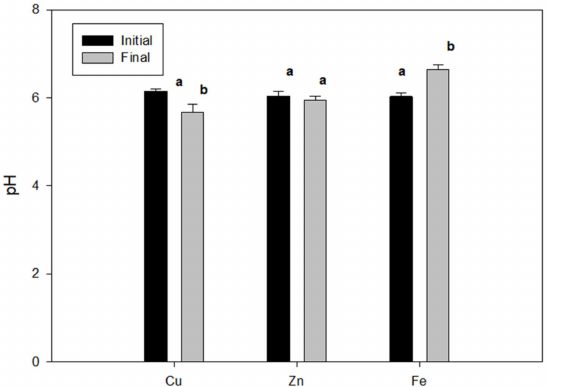
Figure A6. The pH of adsorption equilibrium solutions. Initial and final histograms with different letter mean significant differences according to Tukey-Kramer multiple comparison test ( p ≤